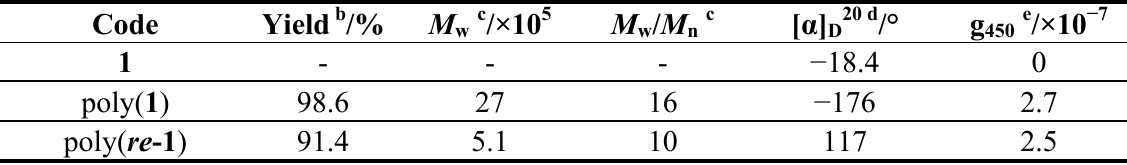
Table 1. Characterizations of 1 , poly( 1 ) a and poly( re -1 ).